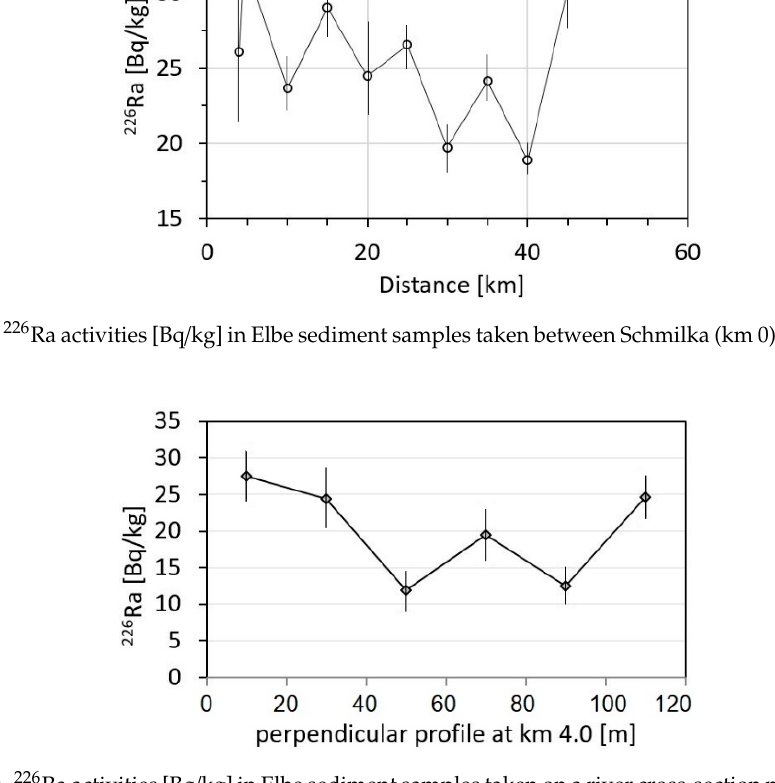
Figure 10. 226 Ra activities [Bq / kg] in Elbe sediment samples taken on a river cross-section near Schmilka.